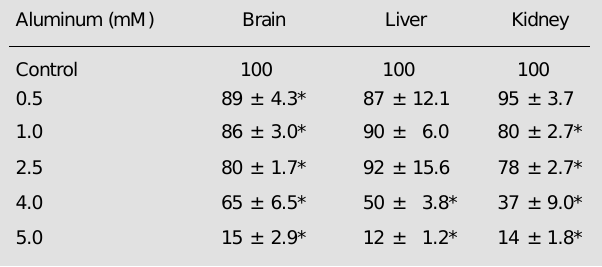
Table 1 - In vitro effect of aluminum sulfate on delta-aminolevulinic acid dehydratase (ALA-D) from brain, liver and kidney of adult mice. Data are reported as mean ± SEM for at least three experiments.